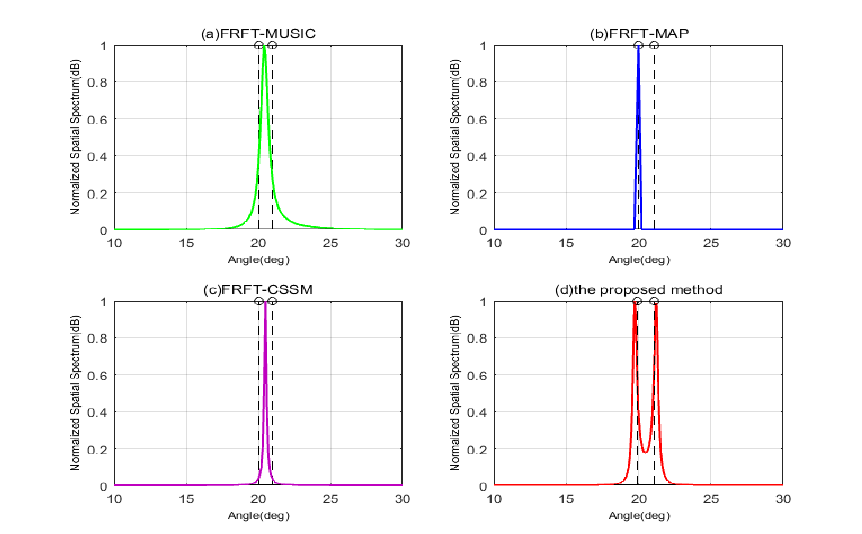
Figure 6. The normalized MUSIC spatial spectrums by four different algorithms with SNR = 10 dB, ∆ θ = 1 ◦ . ( a ) FRFT-MUSIC; ( b ) FRFT-MAP; ( c ) FRFT-CSSM; ( d ) The proposed